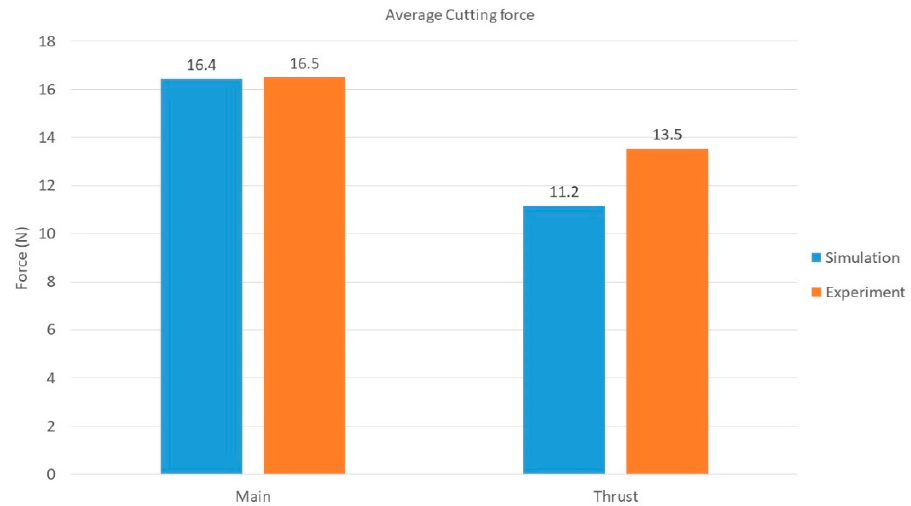
Figure 4. Cutting force comparison for the simulation and experimental results.